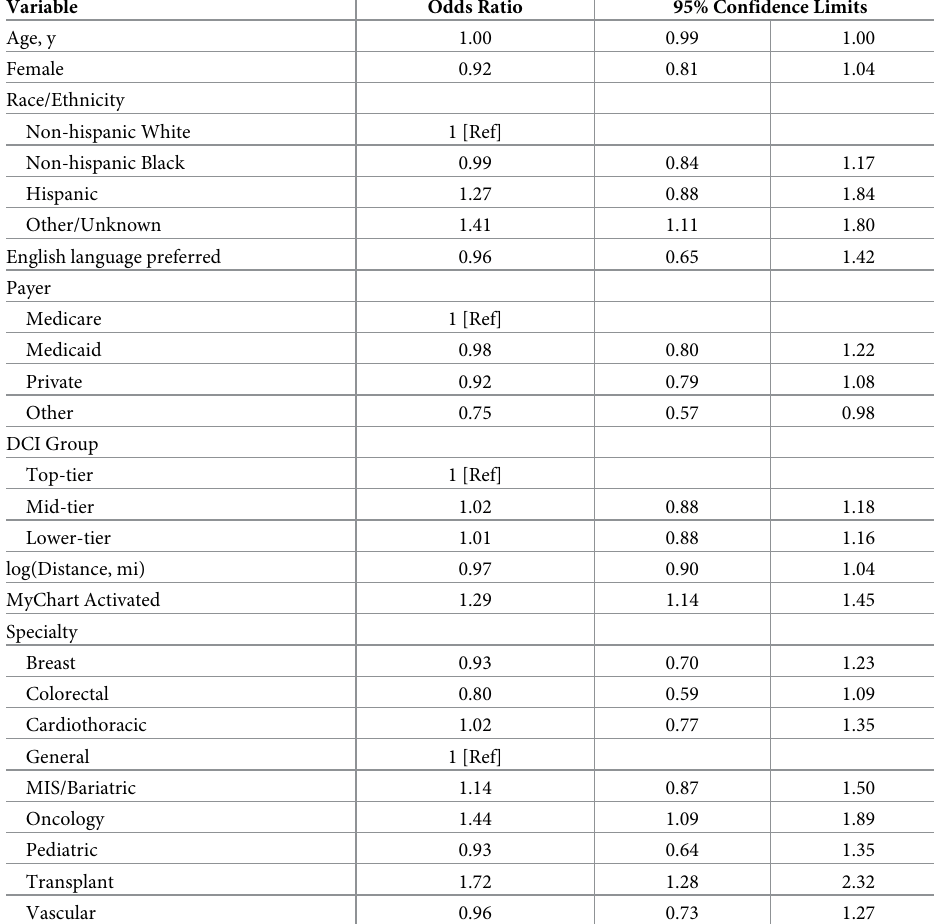
Table 3. Patient characteristics associated with an in-person visit during COVID-19, compared to in-person visits before